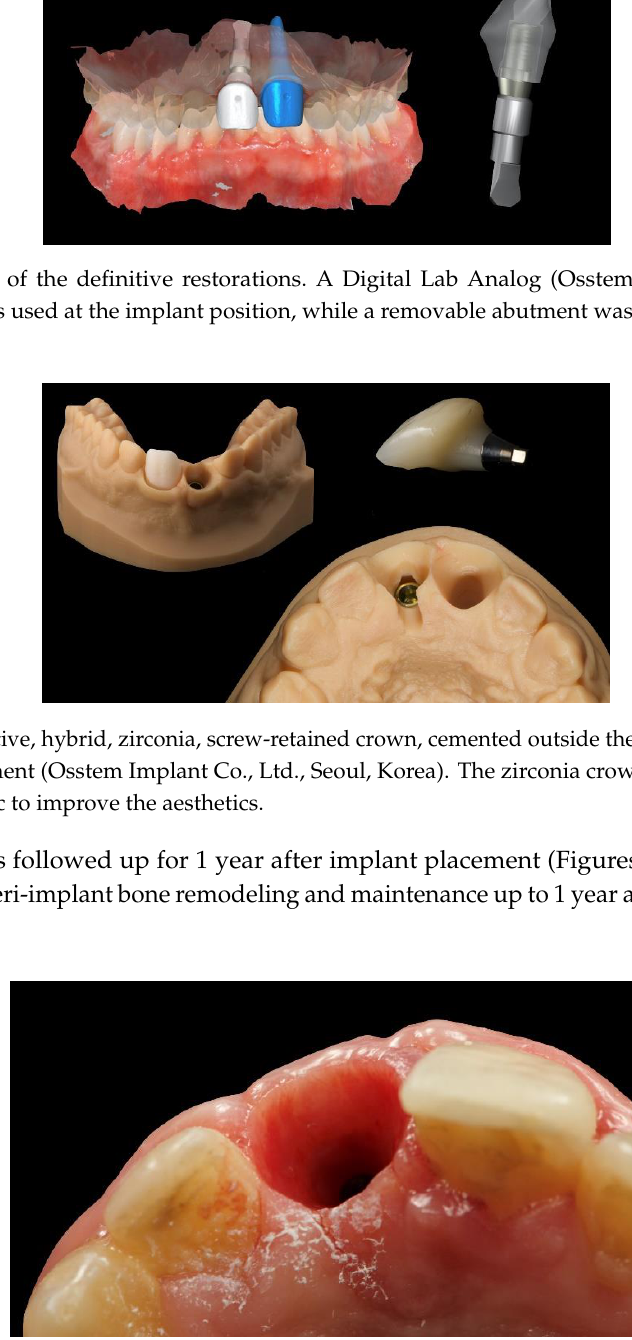
Figure 15. Intraoral front 1 year after implant placement (2 months after definitive-restoration delivery).